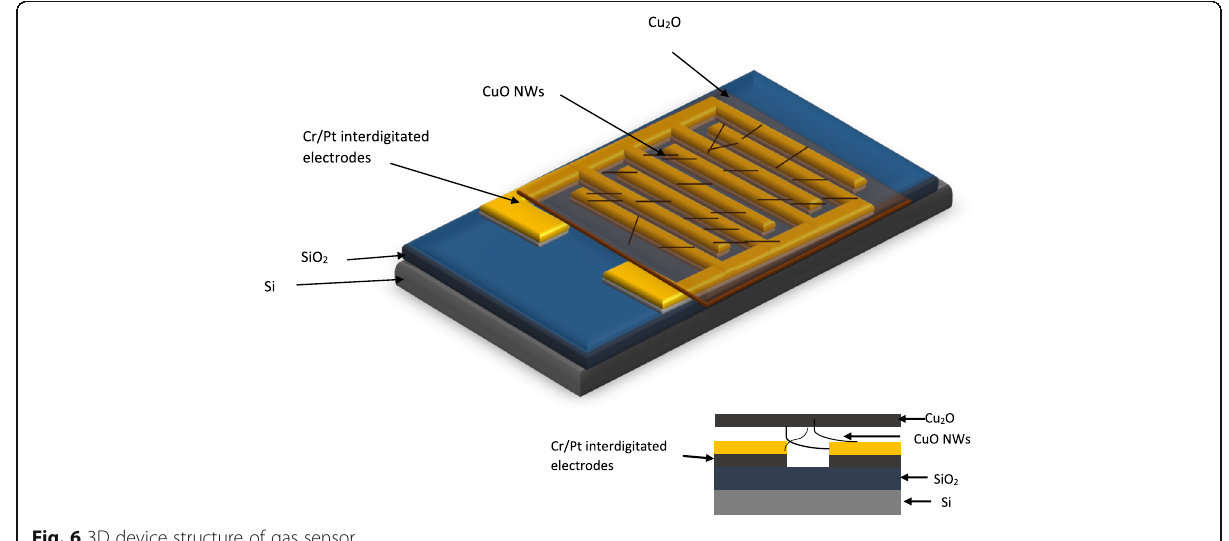
Fig. 6 3D device structure of gas